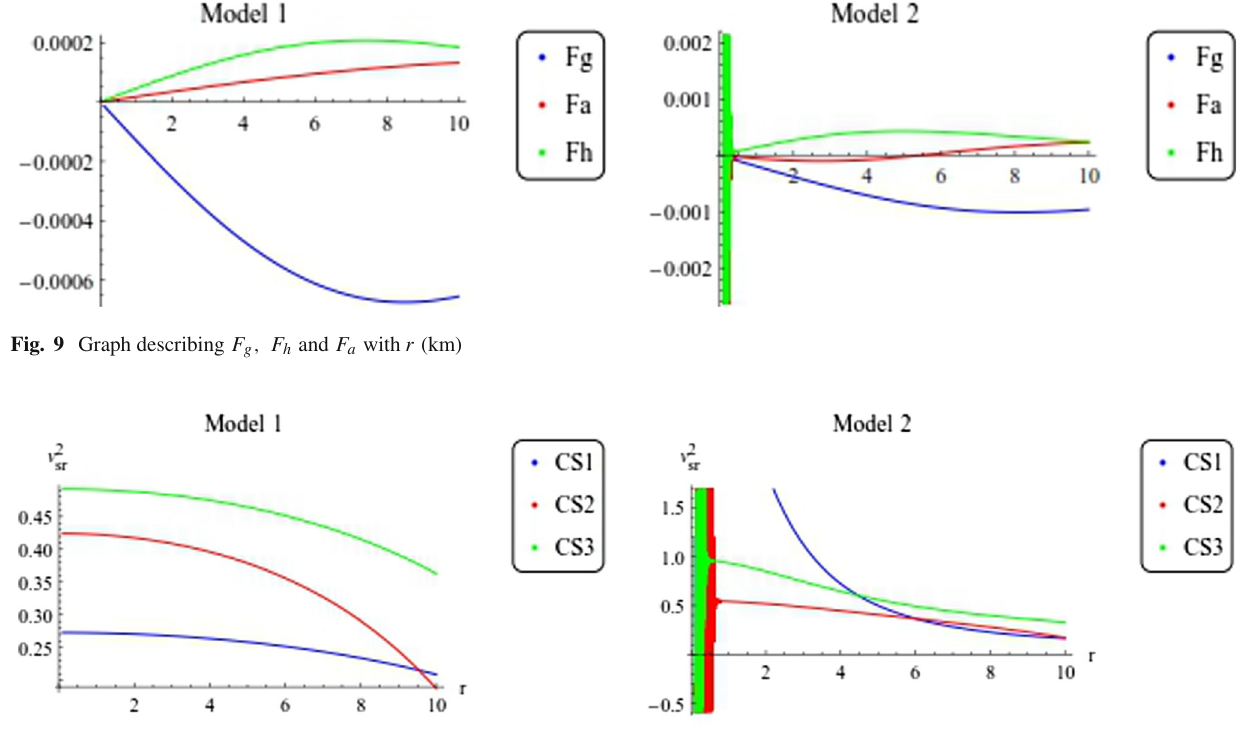
Fig. 10 Change in v 2 sr versus r (km) of CS1, CS2 and